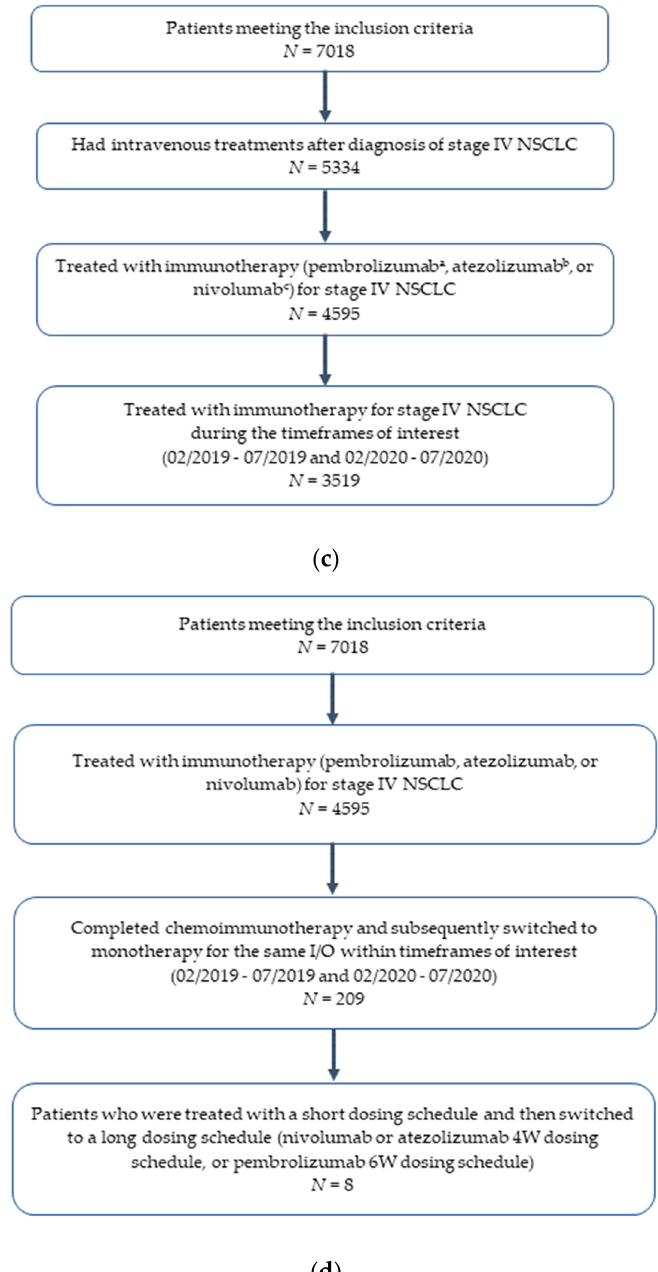
Figure 1. Patient selection flowchart for ( a ) patients meeting the inclusion criteria ( b ) patients with newly diagnosed stage IV NSCLC ( c ) new and continuing immunotherapy-treated patients ( d ) switchers; 4W, once every 4 weeks dosing; 6W, once every 6 weeks dosing; I/O, immuno-oncology agent; NSCLC, non-small cell lung cancer. Recommended dosing schedules for metastatic NSCLC; a Pembrolizumab 200 mg q3w or 400 mg q6w (FDA approval of longer dosing